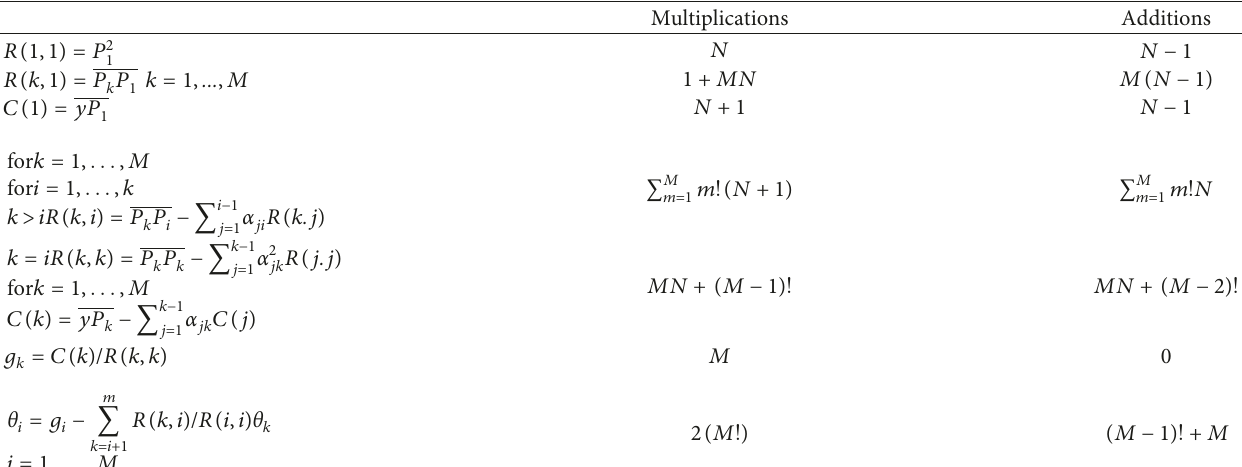
Table 2: C omputational burdens for the Schmidt method algorithm